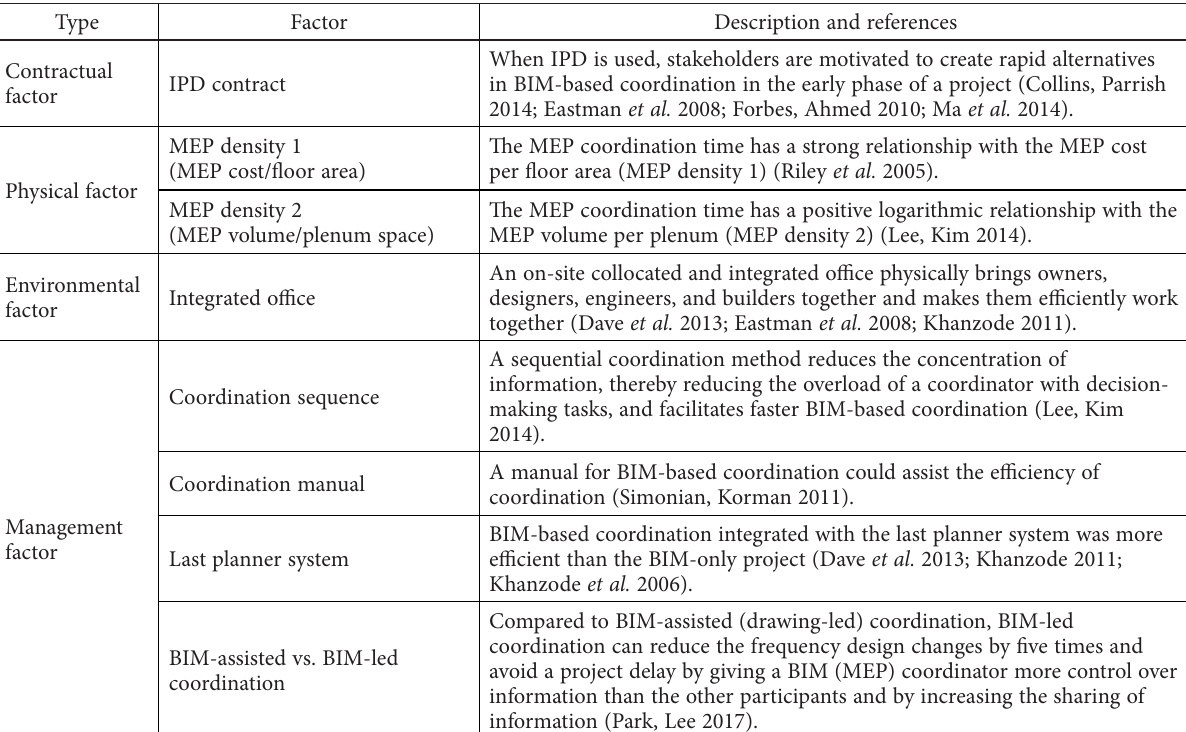
Table 1. Major factors affecting coordination efficiency in the